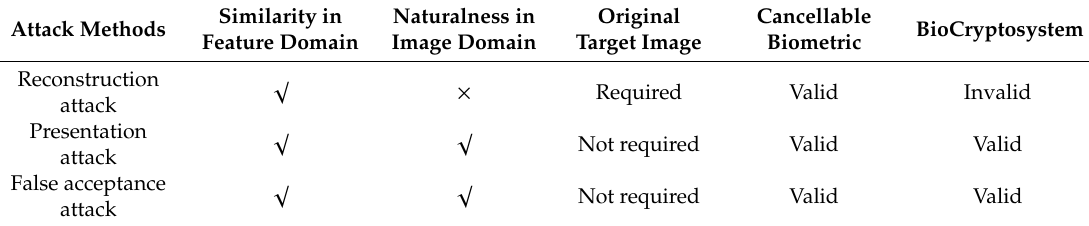
Table 1. Comparison of three image-level attacks counterfeiting biometric image.